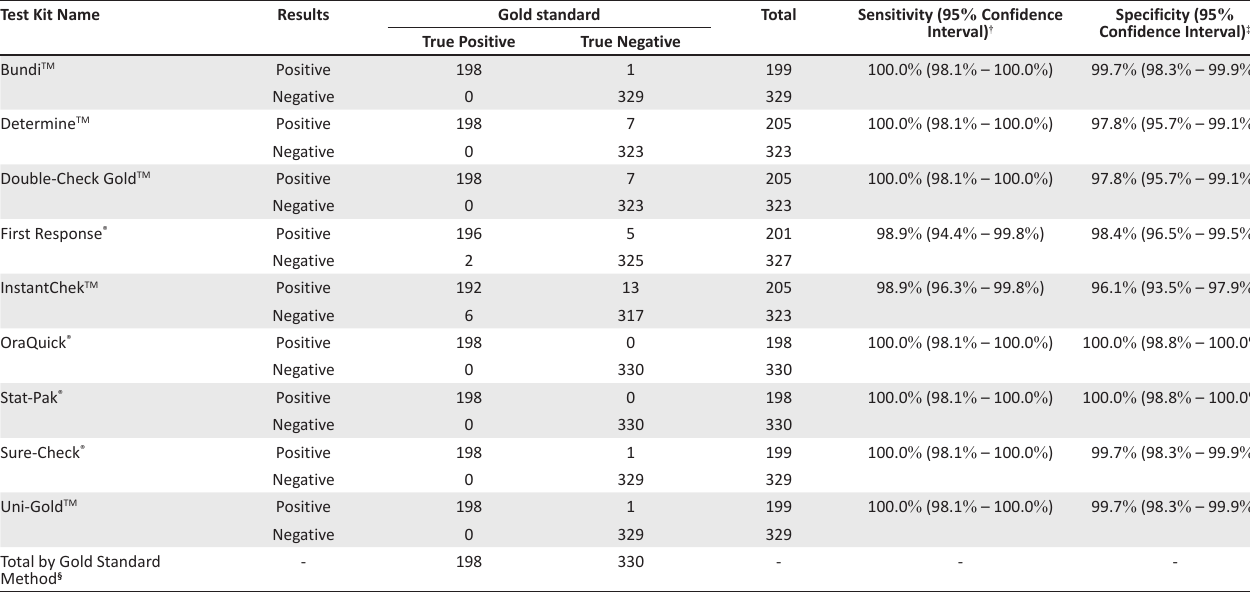
TABLE 2: Sensitivity and specificity calculations for the nine selected rapid test